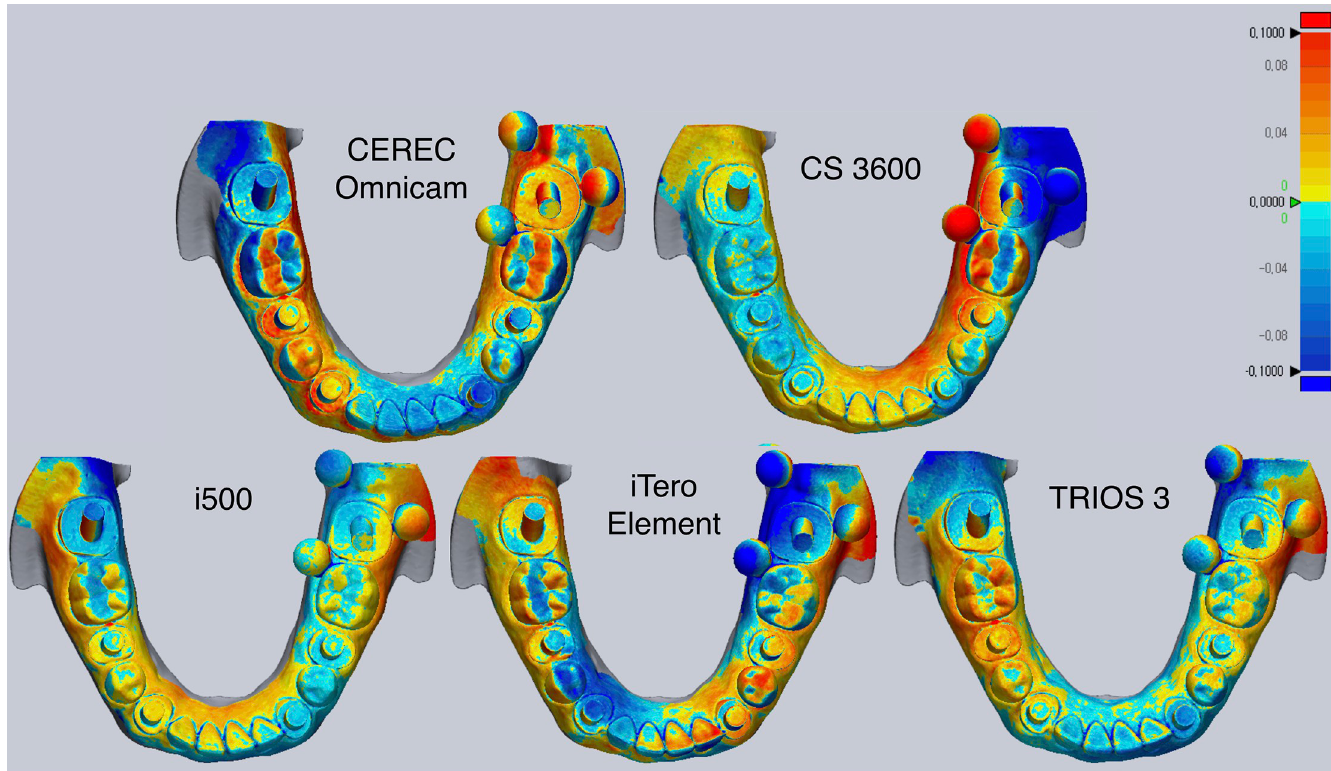
Fig 3. Representative deviation of 3D digital casts. Range of deviation is color-coded from − 100 μ m (blue) to +100 μ m (red).